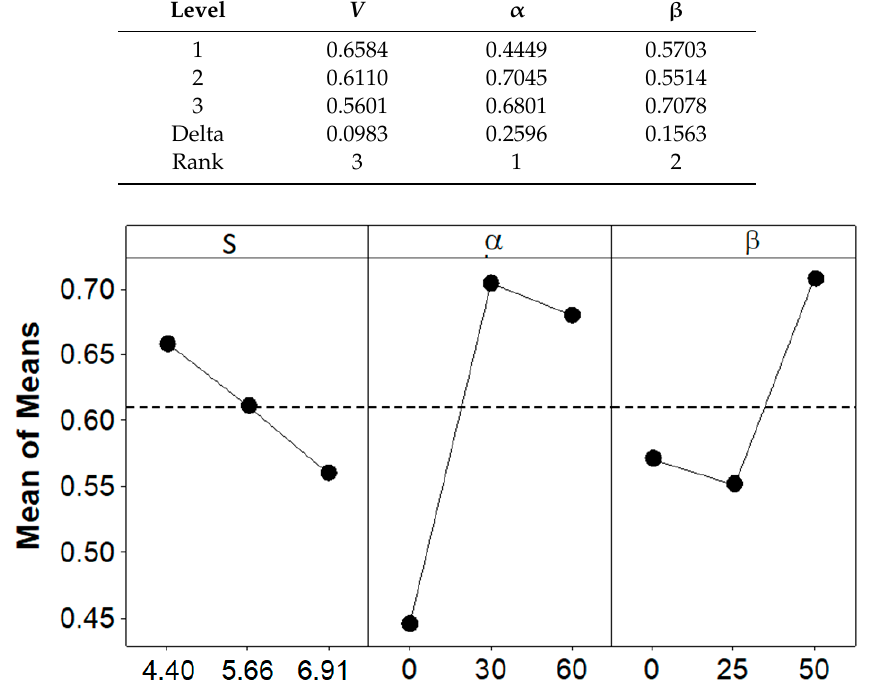
Figure 4. Factor e ff ects on grade values. Figure 4. Factor effects on grade values.